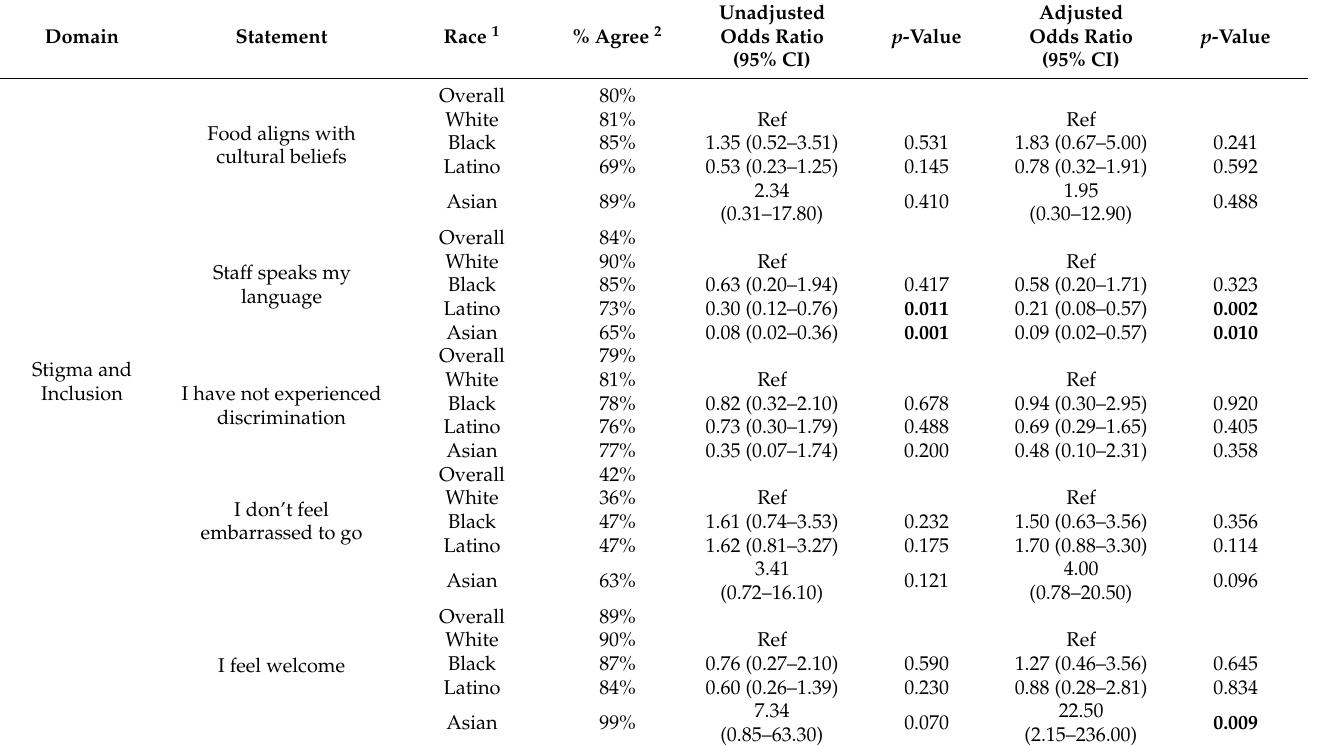
Table 4. Crude and adjusted odds ratios for statements pertaining to food pantry experiences by race, n =